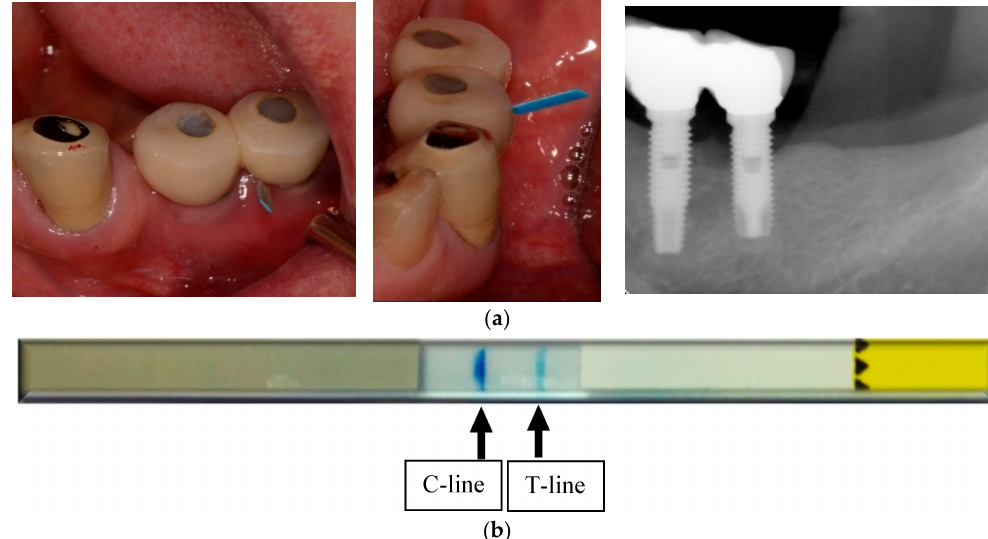
Figure 5. ( a ) Demonstrate the clinical and radiographic features of peri-implantitis and use of ImplantSafe; ( b ) Two clear lines indicate elevated risk for peri-implantitis. A positive test result: both control (C) line and test (T) line are visible, reveals elevated collagenolytic activity.